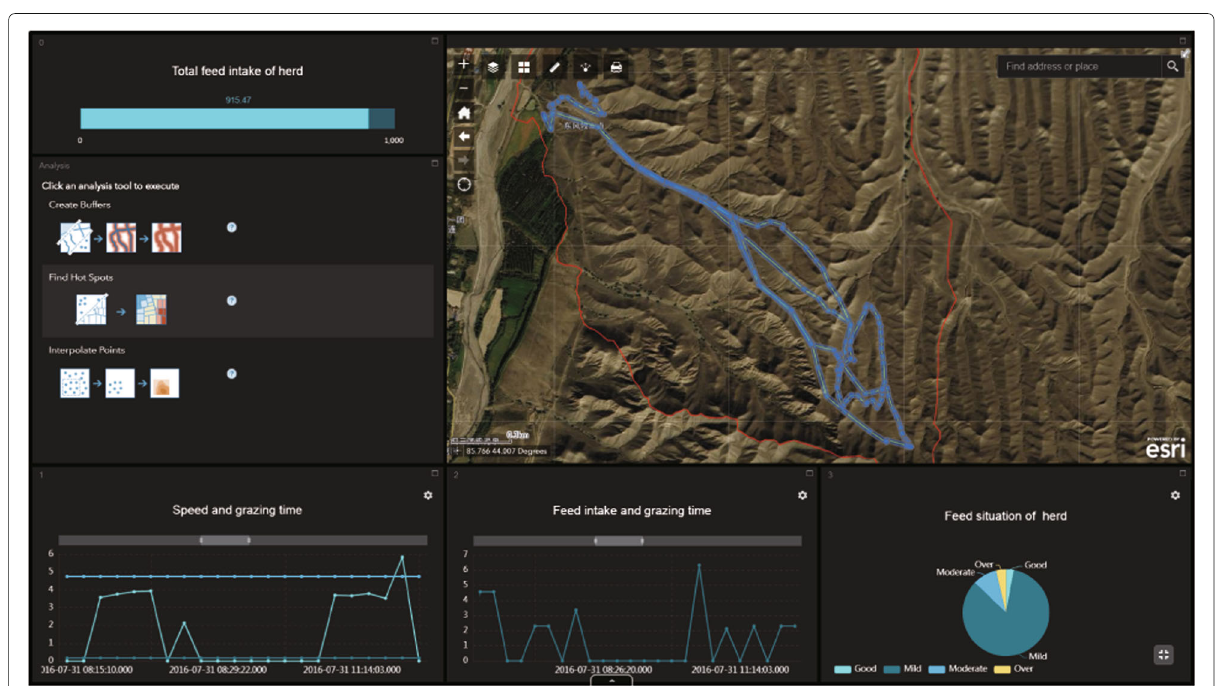
Fig. 9 The buffer analysis result diagram of the platform